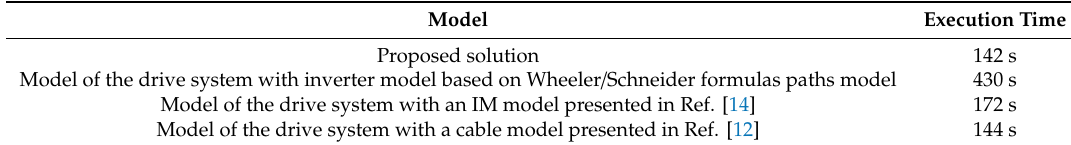
Table 4. Total execution time of simulation for individual models.